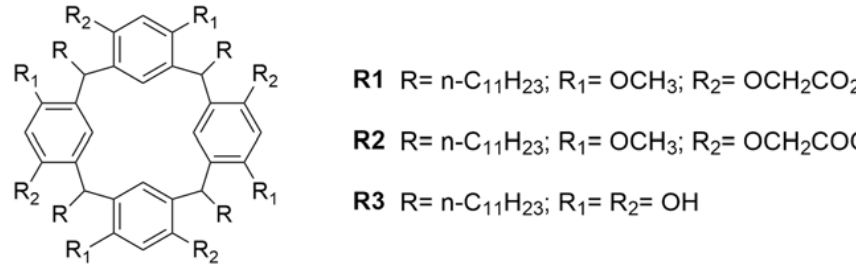
Figure 1. Chemical structure of amphiphilic resorc[4]arenes R1 , R2, and R3 .